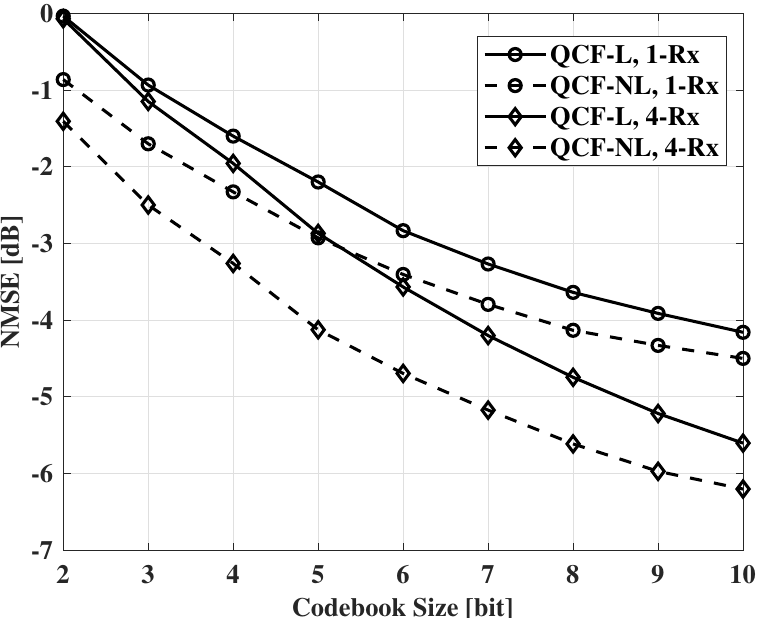
Figure 4. NMSE measurements according to codebook size, SNR = 10 dB, N t = 32, and N r = 1,4.